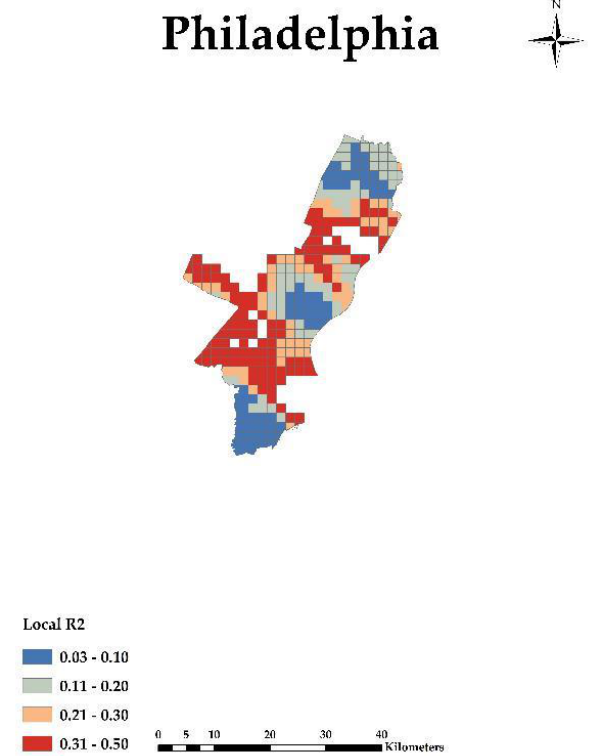
Figure 19. Philadelphia shrinking city: GWR Local r-squared.